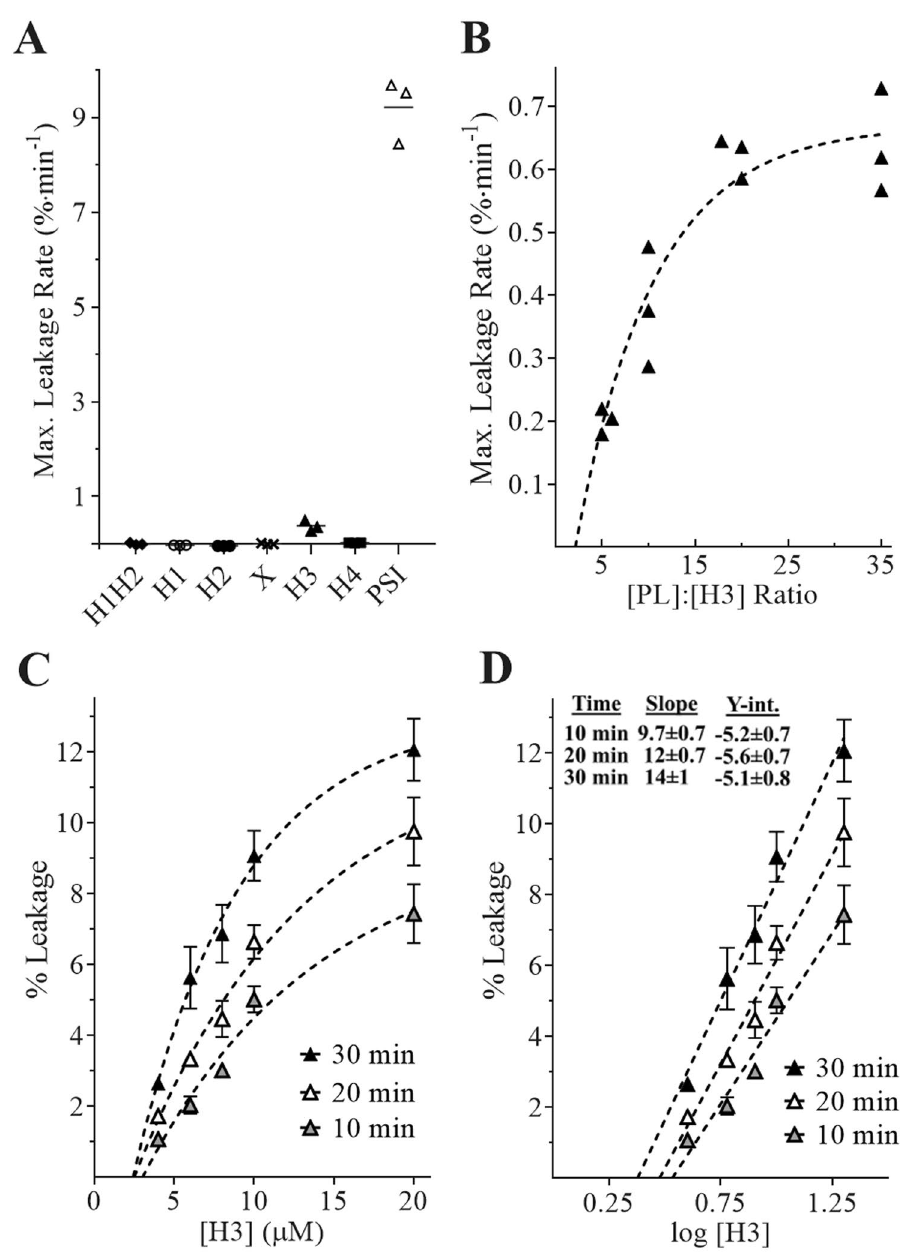
Figure 10. Leakage assays for peptide-treated 1:1 POPE:POPS bilayer vesicles in 50 mM sodium acetate/140 mM NaCl buffer pH 4.5 at 25 °C. ( A ) Peptide screening assays for vesicle leakage activity used 40 µ M H1H2, H2, X, and H5; and 10 µ M H1 (low solubility of H1 prevented screening above 10 µ M). The bilayer disruption activity of PSI is shown for comparison. ( B ) Leakage rate-dependence on [phospholipid]:[H3] ratio; and ( C , D ) Extent of leakage induced by 4–20 µ M H3 (mean + / − one standard deviation, n = 3). Leakage was non-linearly proportional to H3 concentration, and semi log curves were significantly different (P ≤